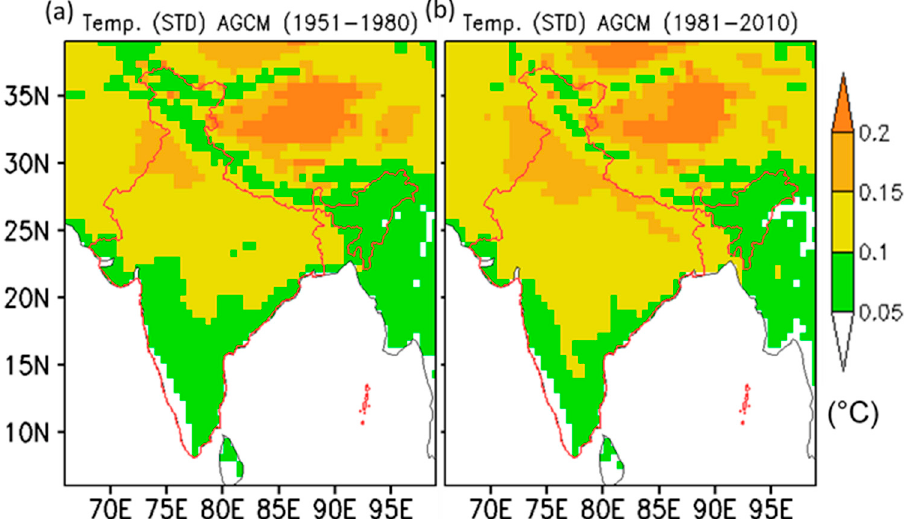
Figure 10. Standard deviation of the temperature climatologies derived from all ensemble members in two climate periods ( a ) 1951–1980 and ( b ) 1981–2010.